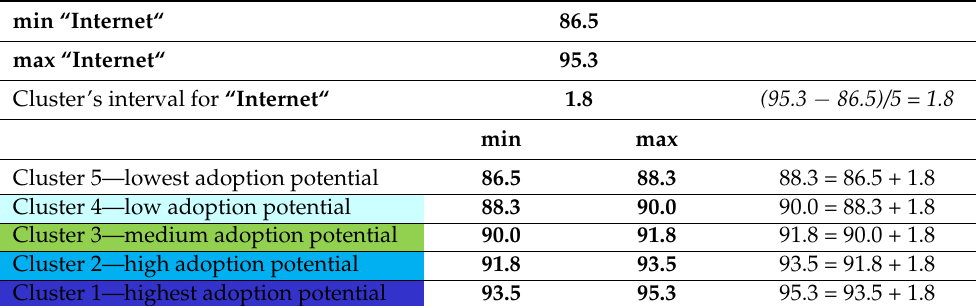
Table 13. Calculations for the “cluster interval” for variable “Internet“.